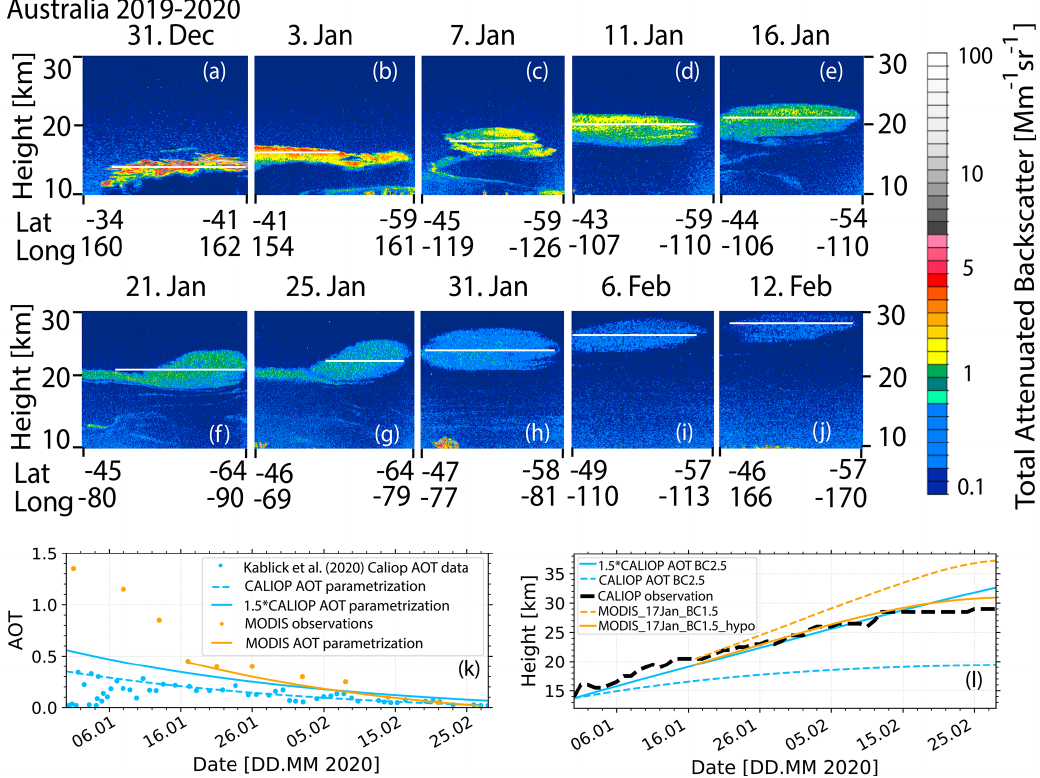
Figure 13. (a–j) Height–time display of the total 532nm attenuated backscatter coefficient of an Australian wildfire smoke layer observed with CALIOP on 10 different days within the 6.5-week period. The white horizontal lines indicate the layer center height of the ascending smoke layer. In panel (k) , the AOT observations are given, used in the simulations in panel (l) , retrieved from MODIS observations (orange dots, parameterization as orange line), and derived from the CALIOP observations (blue dots; Kablick et al., 2020; parameterization in dashed blue, 1 . 5 × AOT parameterization as a solid blue line). By using the MODIS and CALIOP AOT parameterizations (MODIS parametrization and simulations start on 17 January), the heating rates and subsequent lofting rates are simulated, shown in panel (l) , and compared with the observed lofting rates (dashed black line). The different CALIOP AOT parameterizations (blue) were used together with a BC fraction of 2.5%. In the case of the simulations with the MODIS AOT parameterization (orange, BC fraction of 1.5%), the simulations start at different (initial) layer heights. In the simulation, shown in orange (MODIS_17Jan_BC1.5_hypo), the starting height was decreased by 1km.